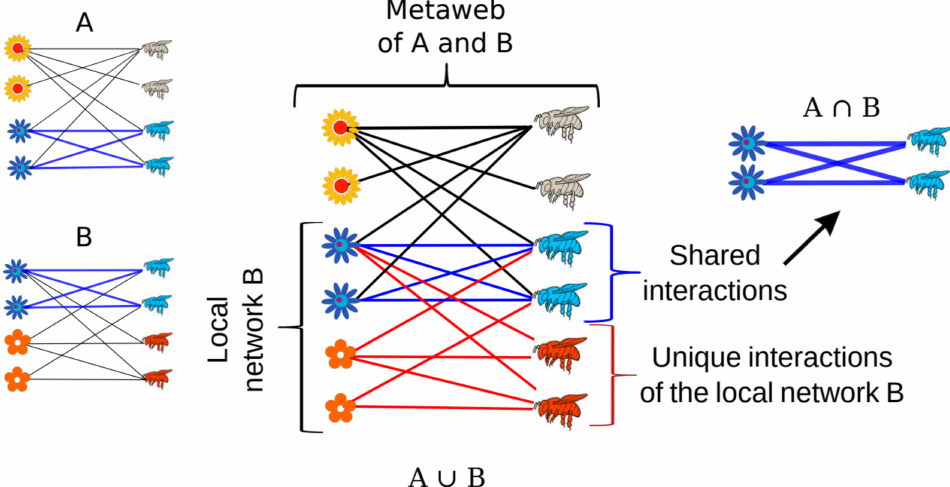
Figure 4. Representation of how merging networks A and B can result in their metaweb, thus the metaweb is the union of A and B (A ∪ B). The metaweb contains the interactions of both networks and it has several characteristics that can be measured. For example, we can see that there is a subset of interaction shared between A and B (blue species and lines), this is the intersection of A and B (A ∩ B). We can also see that both A and B have a subset of unique interactions (black and red lines of the metaweb). Note that two or more networks can form a